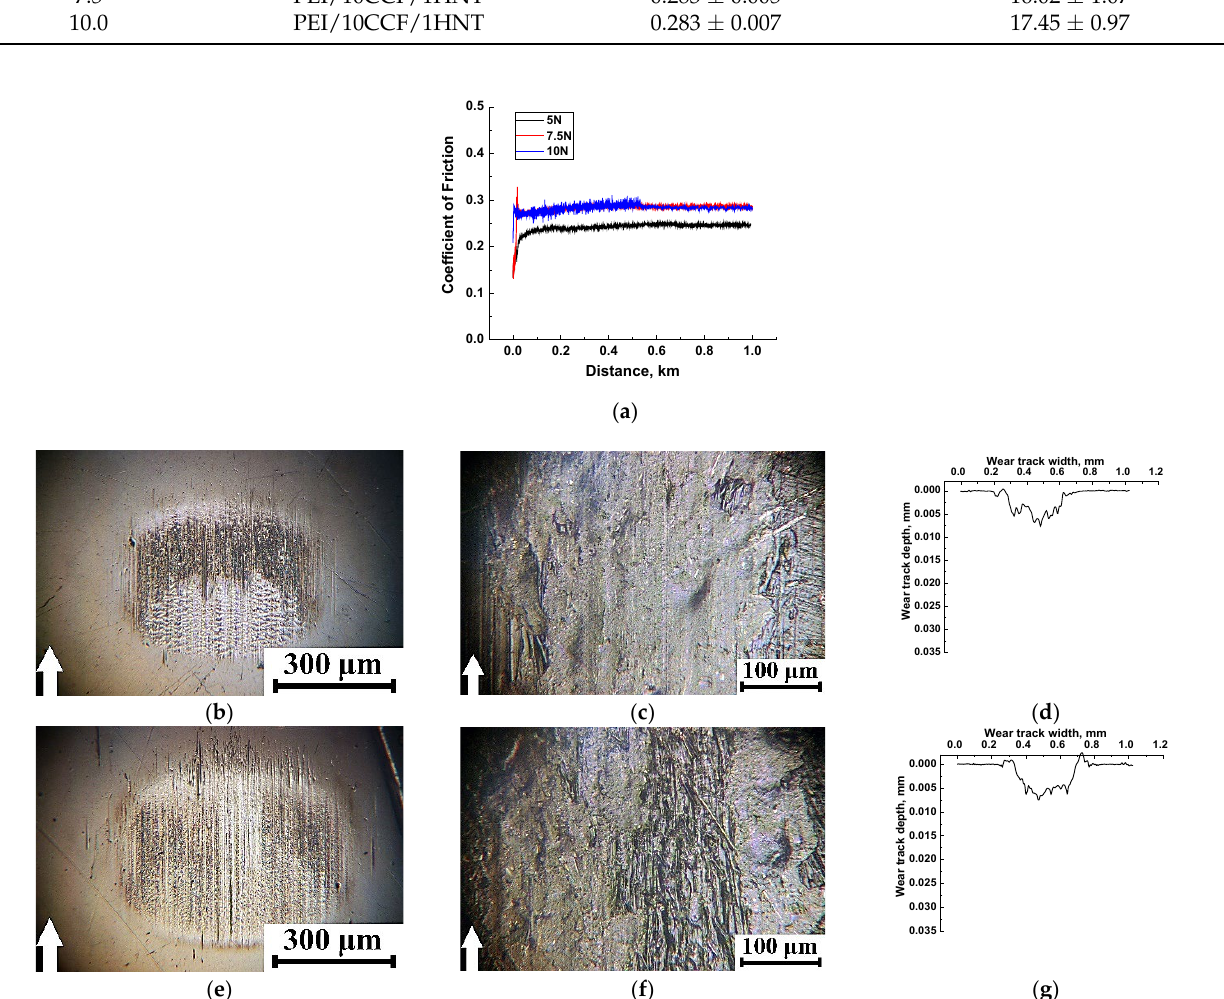
P , N Composition (wt.%)